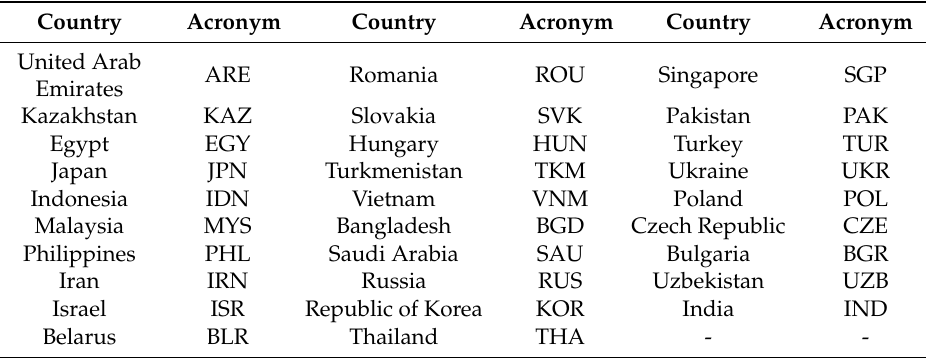
Table 1. Acronyms of the 29 examined B&R